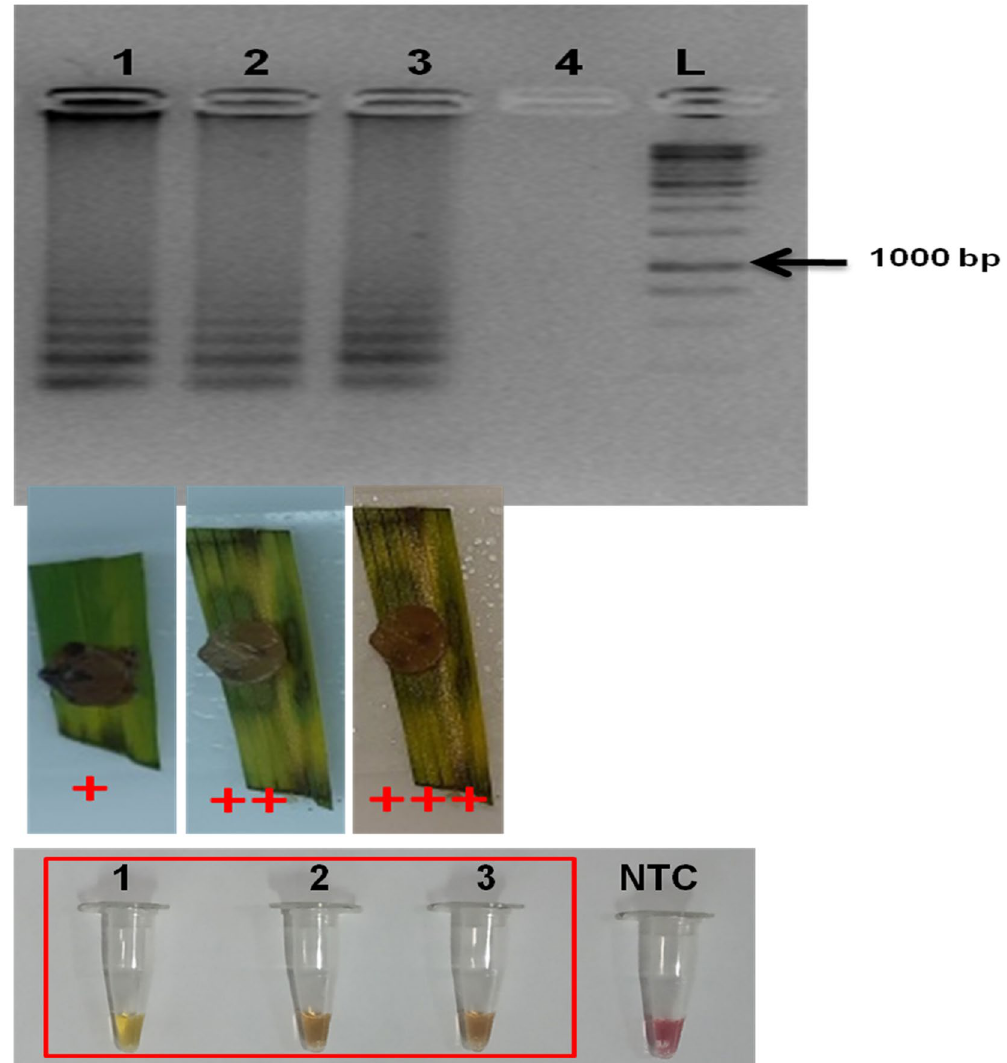
Figure 6. LAMP assay with infected rice leaves of different severity levels (artificial infection). 1: R. solani AG-1 IA isolate PURS2 (severity: +); 2: R. solani AG-1 IA isolate PURS2 (severity: ++); 3: R. solani AG-1 IA isolate PURS2 (severity: +++); 4: No template control; L: 1 kb (Generuler). Upper panel in the figure shows agarose gel electrophoresis results, middle panel shows diseases severity in the samples and lower panel shows reaction